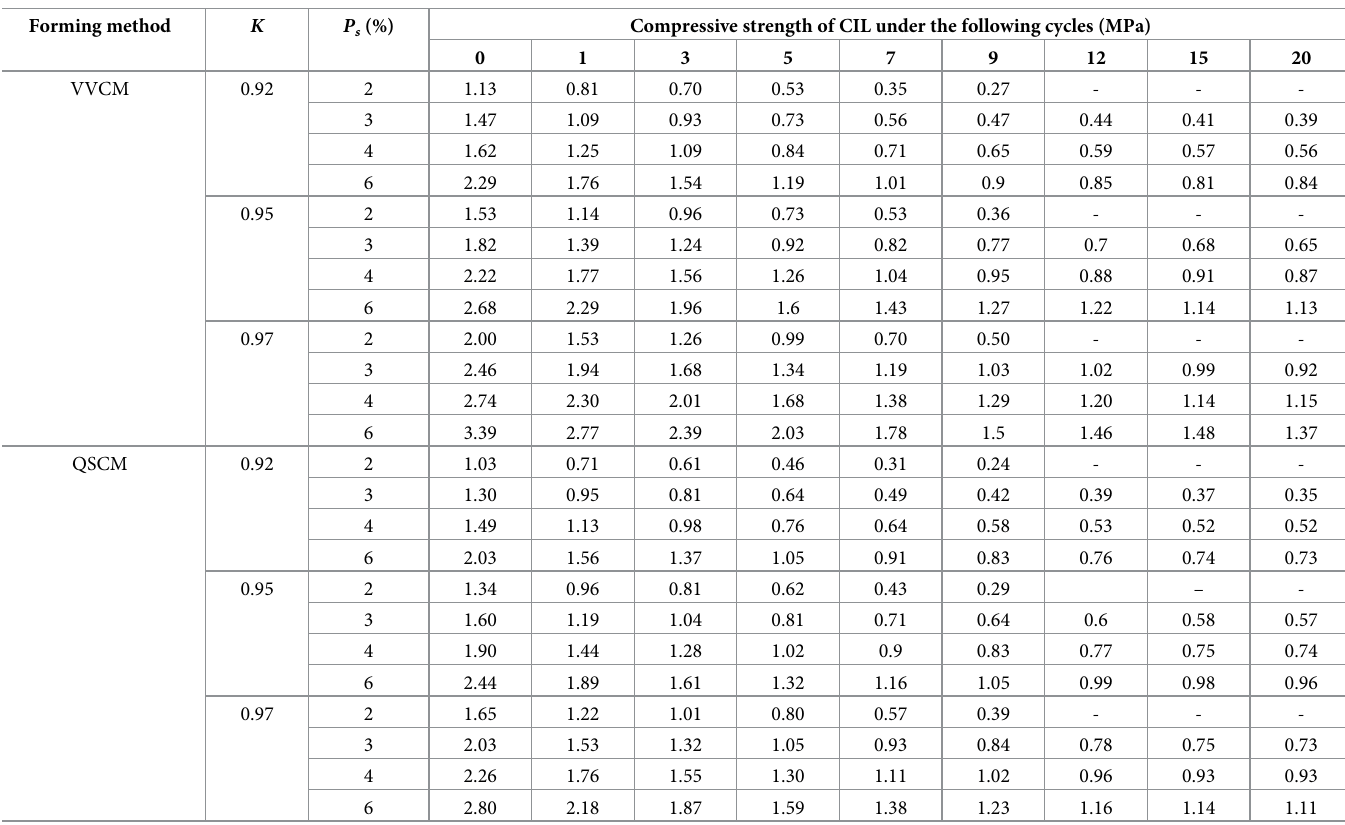
Table 4. 28d compressive strength of CIL under freeze–thaw cycles. Forming